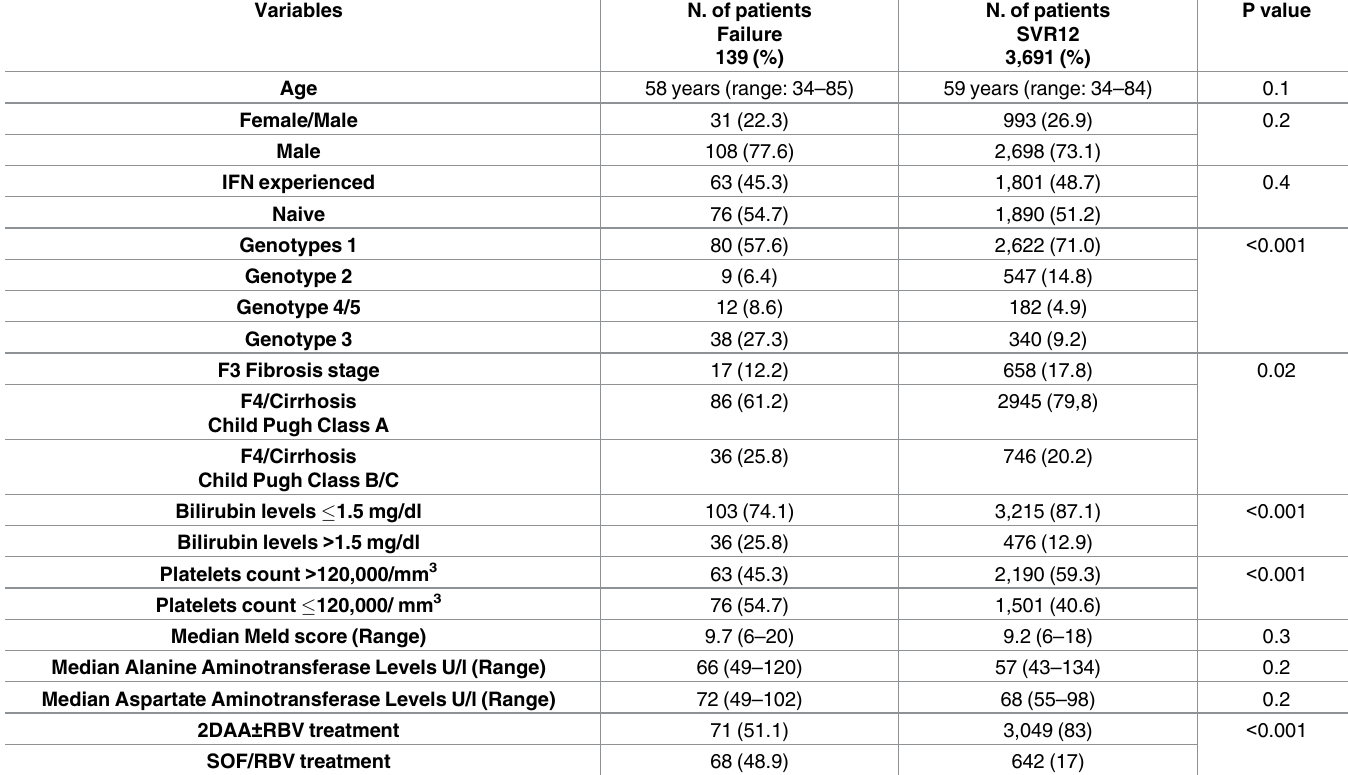
Table 1. Characteristics of the study patients according to SVR following the first DAA treatment.